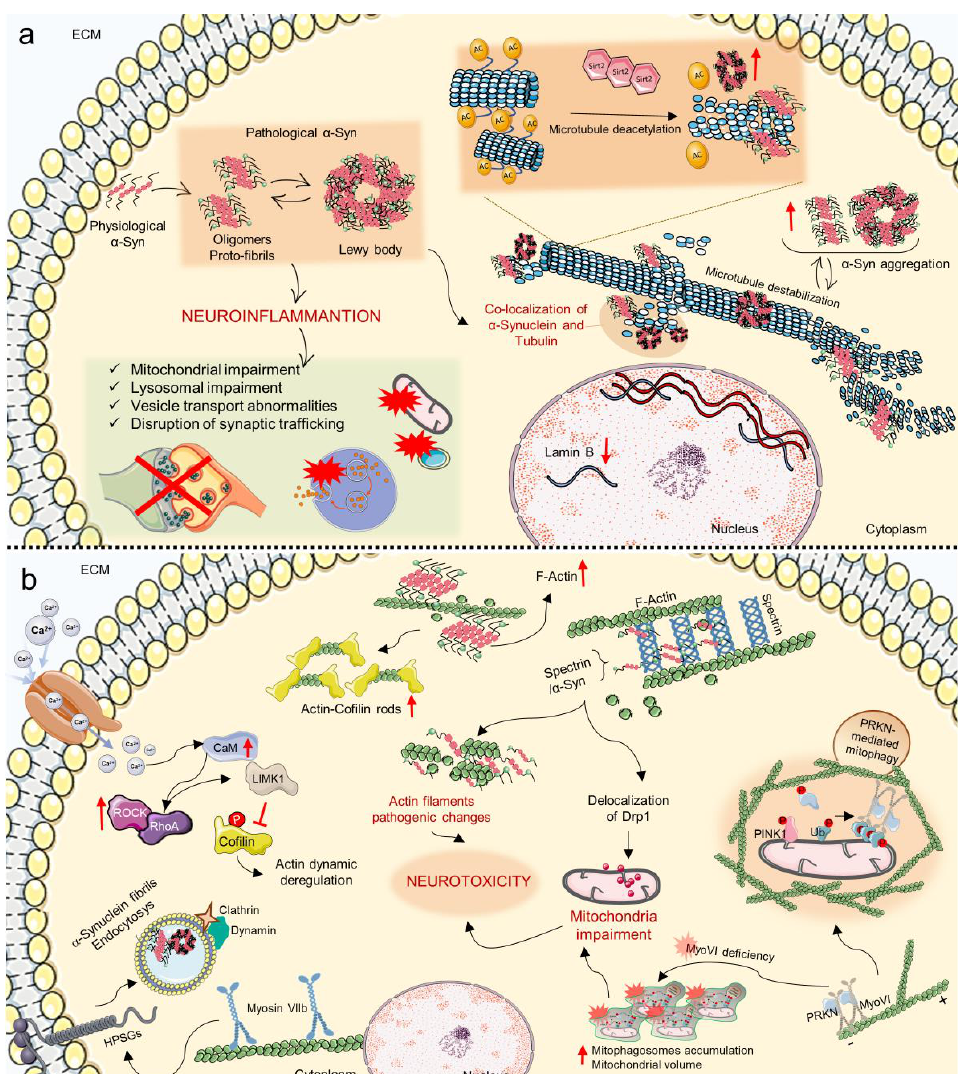
Figure 6. Biochemical pathways of cellular mechanosensing and mechanotransduction involved in Parkinson’s Disease pathological mechanisms: ( a ) Pathogenic molecular mechanism of α -Synuclein aggregation and Lewy bodies formation and effects on cellular homeostasis, microtubules dynamic, nucleoskeletal architecture, and on ( b ) cytoskeletal Actin dynamic and its involvement in mitochon- dria homeostasis and α -Synuclein endocytosis (see main text for details). Red arrows up ↑ or down ↓ indicate up or downregulation. AC, Acetyl; Ca 2+ , Calcium ion; CAM, cell adhesion